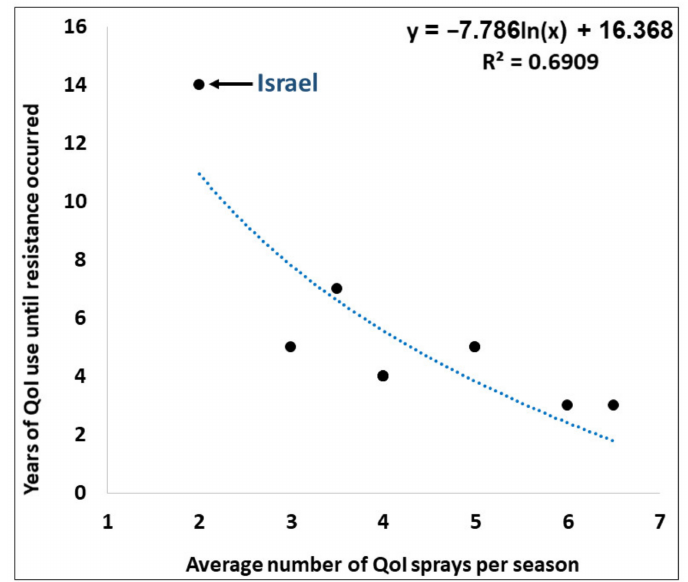
Figure 2. Correlation and logarithmic regression between number of QoI sprays per season and years until occurrence of resistance to QoI. Data points are derived from data on resistance of V. inaequalis to QoI from 10 countries/regions presented in Table 3. Israel is marked by an arrow. R 2 and equation of the regression is